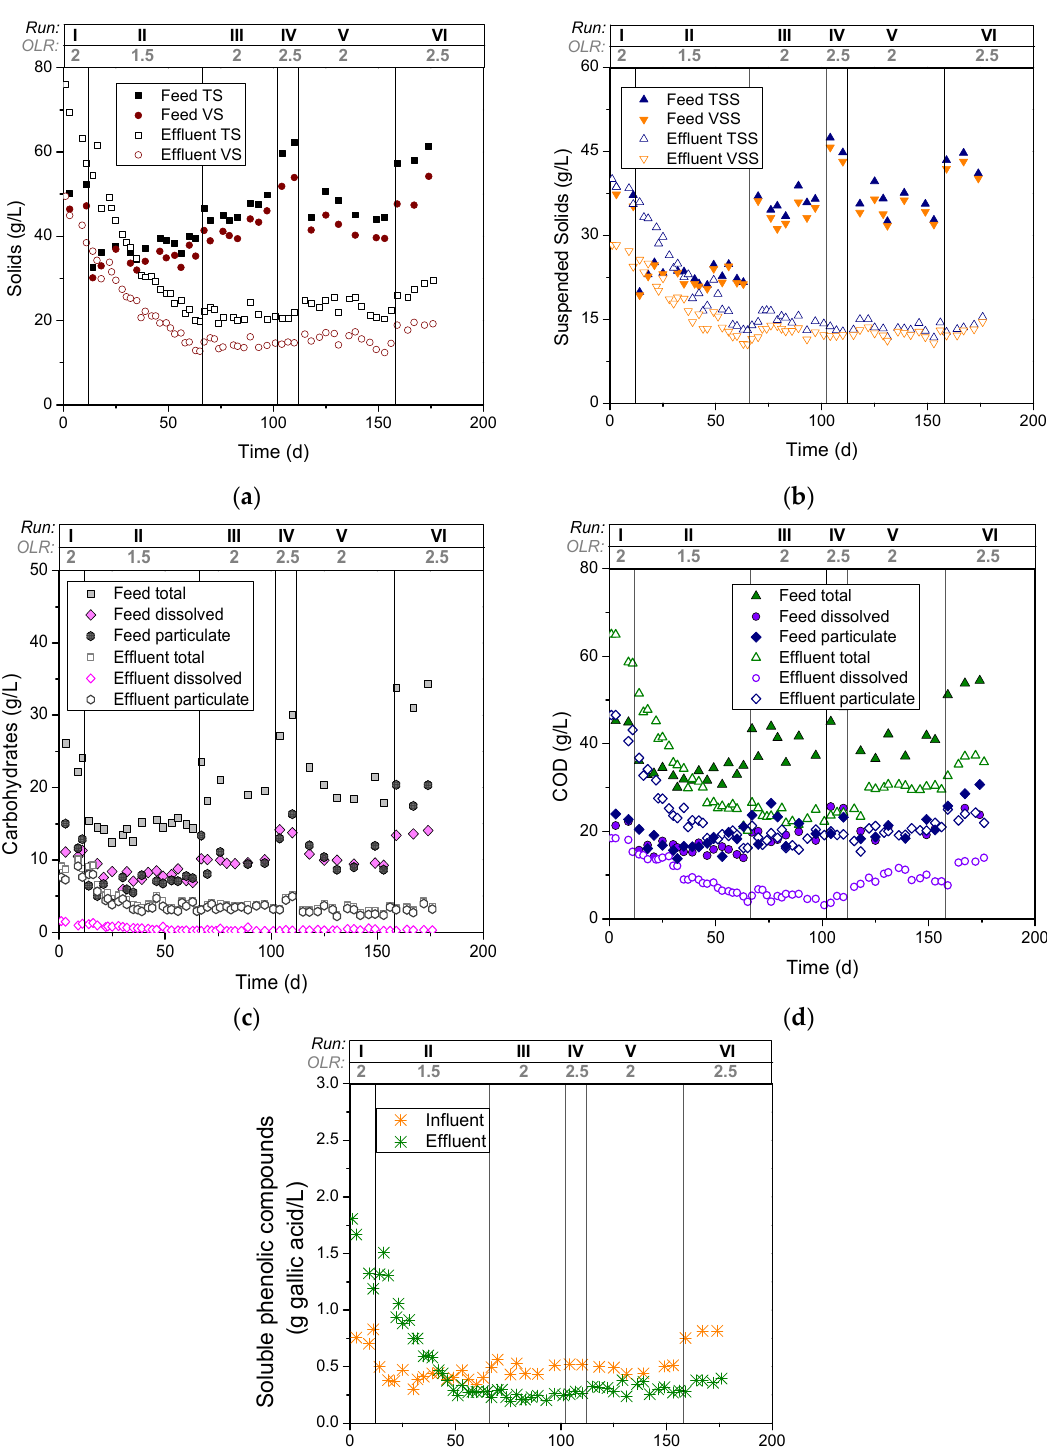
Figure 3. Southern Greece fall/winter scenario: ( a ) Feed and effluent TS, and VS concentration, ( b ) Feed and effluent TSS, and VSS concentration, ( c ) Feed and effluent total, dissolved, and particulate carbohydrates concentration, ( d ) Feed and effluent total, dissolved and particulate COD concentration, ( e ) Feed and effluent soluble phenolic compounds concentration for all the tested runs.